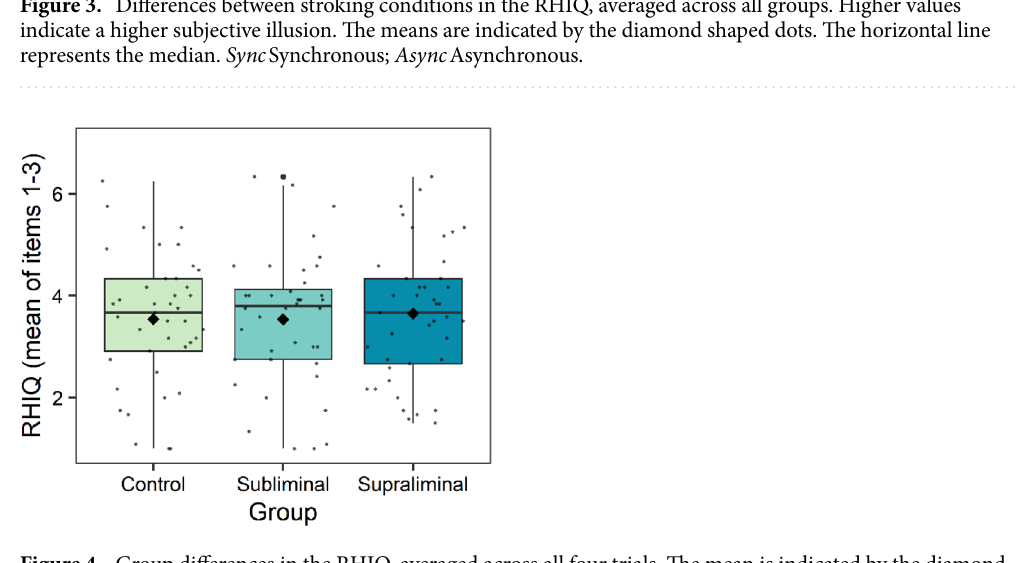
Figure 4. Group differences in the RHIQ, averaged across all four trials. The mean is indicated by the diamond shaped dots. The horizontal line represents the median.